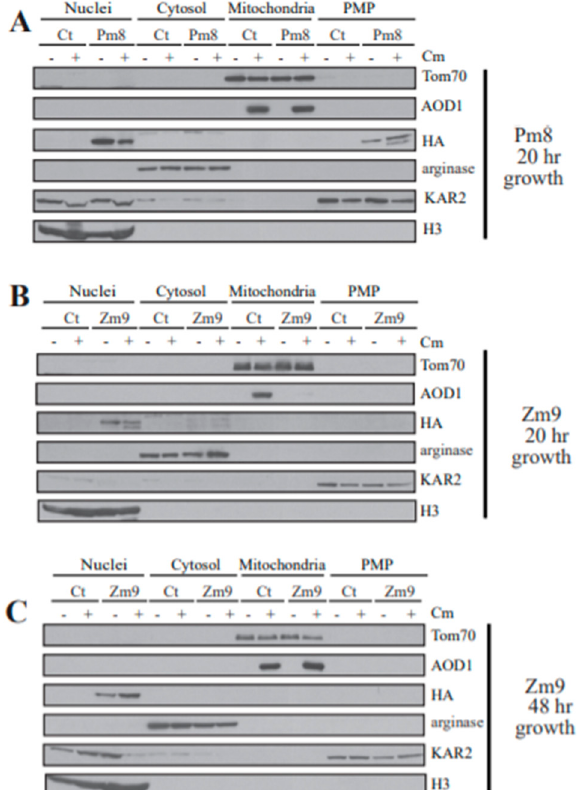
Figure 7. Subcellular fractionation of 3xHA N-terminal tagged P- and Z-mutant YVH1 strains. Nuclei, mitochondria, cytosol, and PMP fractions were isolated as described in the Materials and Methods from phosphatase domain mutant Pm8 ( A ) and from the zinc-binding domain mutant Zm9 ( B , C ) following growth for 20 h ( A , B ) or 48 h ( C ). The control (ct) strain was NCN251. Cultures were grown in the absence ( − ) or presence ( + ) of Cm. Proteins in each fraction were separated by SDS-PAGE, blotted to nitrocellulose membrane and probed with the antibodies indicated on the right. Markers for each fraction were as in the legend to Figure 5.